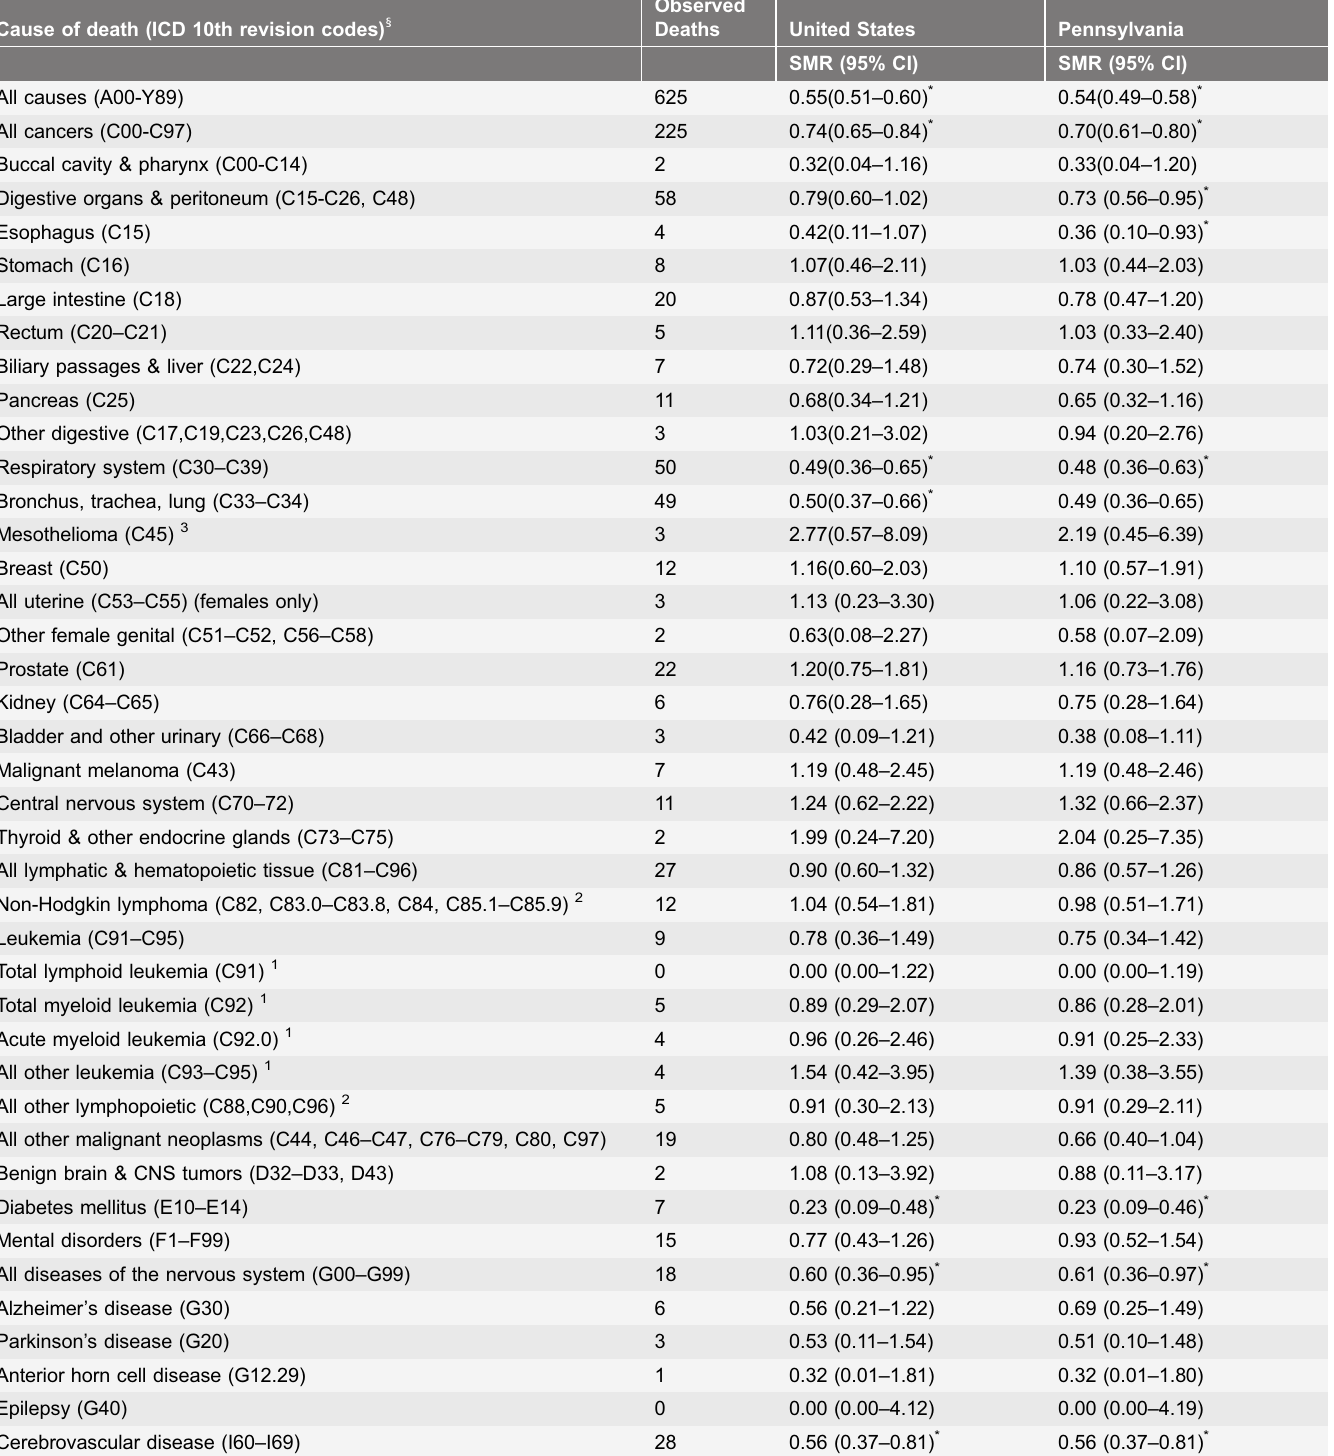
Table 2. Standardized mortality ratio (SMR) and 95% confidence interval (CI) for selected causes of death for all workers based on United States and Pennsylvania comparison